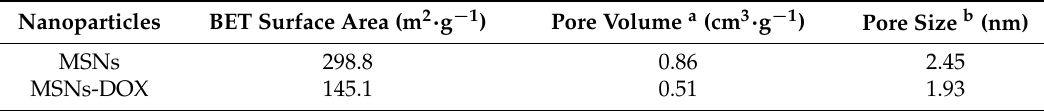
Table 1. BET analysis of MSNs and MSNs-DOX.